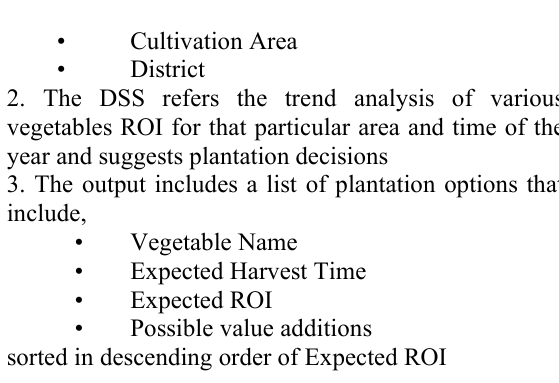
Figure 4. Flowchart for proper plantation for